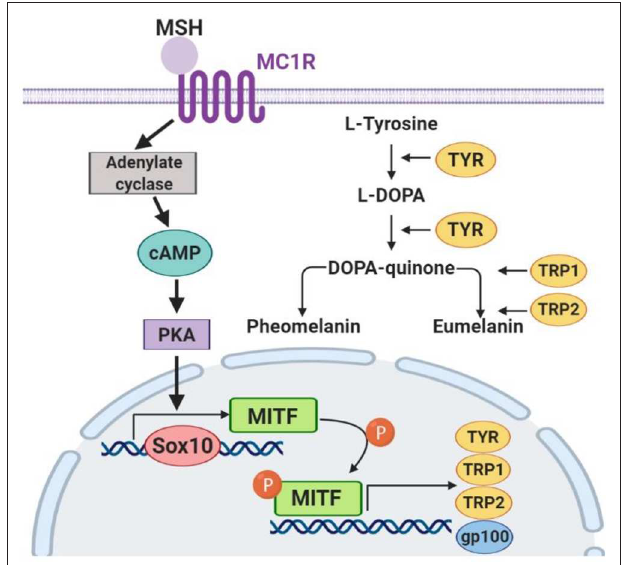
FIGURE 7 | The key components of the melanogenesis signaling